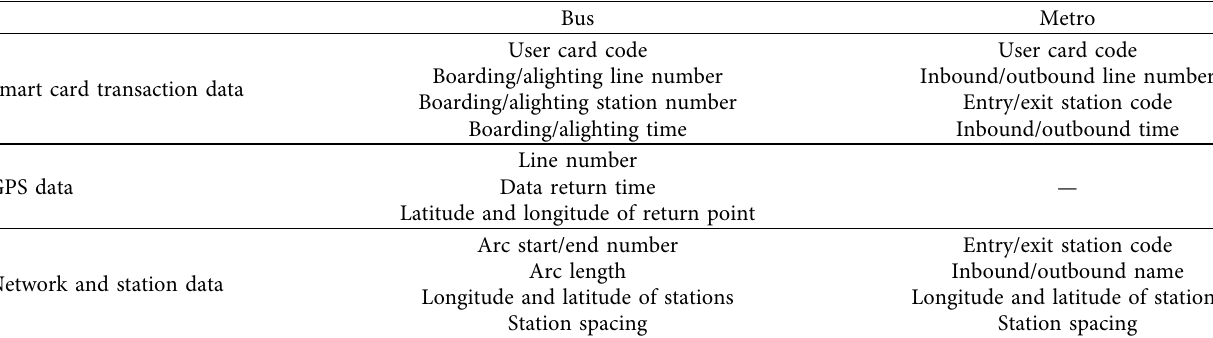
Table 1: Valid fields of multisource PT data.